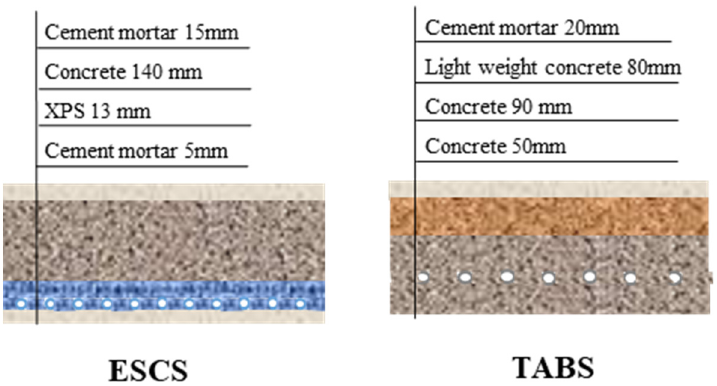
Figure 2. Configurations of radiant system.